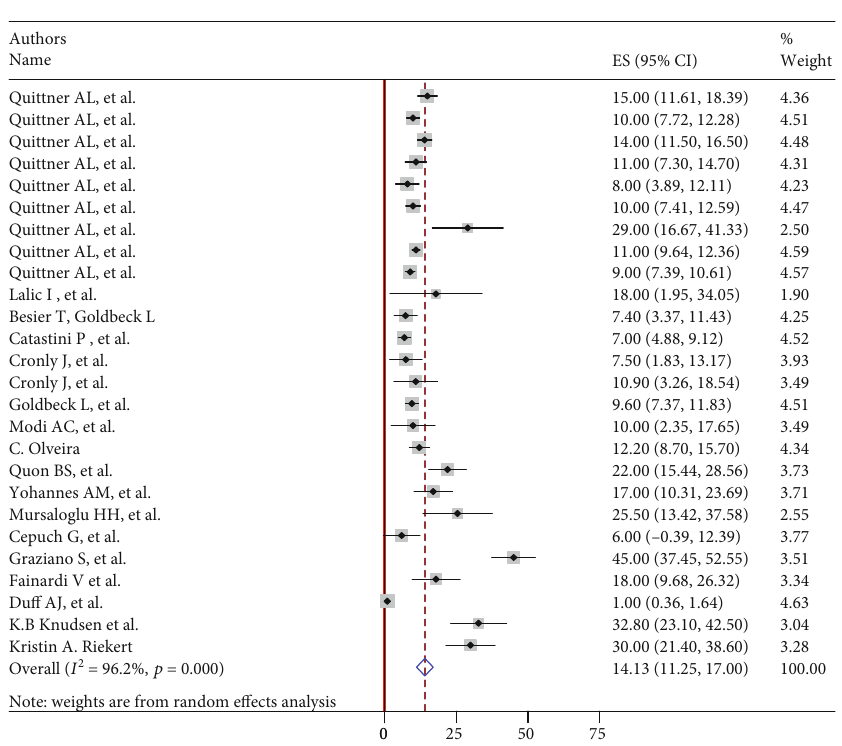
Figure 2: Forest plot showing global pooled prevalence of anxiety in patients with cystic fi brosis.